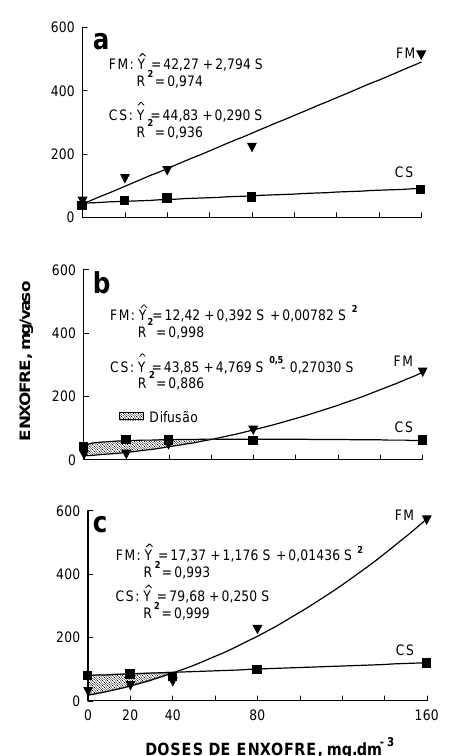
Figura 1. Enxofre potencialmente transportado por fluxo de massa até a superfície das raízes (FM) e conteúdo de enxofre (CS) das plantas de milho, em função das doses de S aplicadas em amostras dos solos de Viçosa (a), de Paracatu (b) e de Lassance